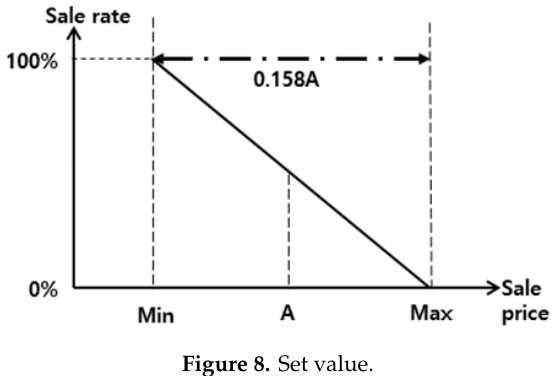
Figure 8. Set value.